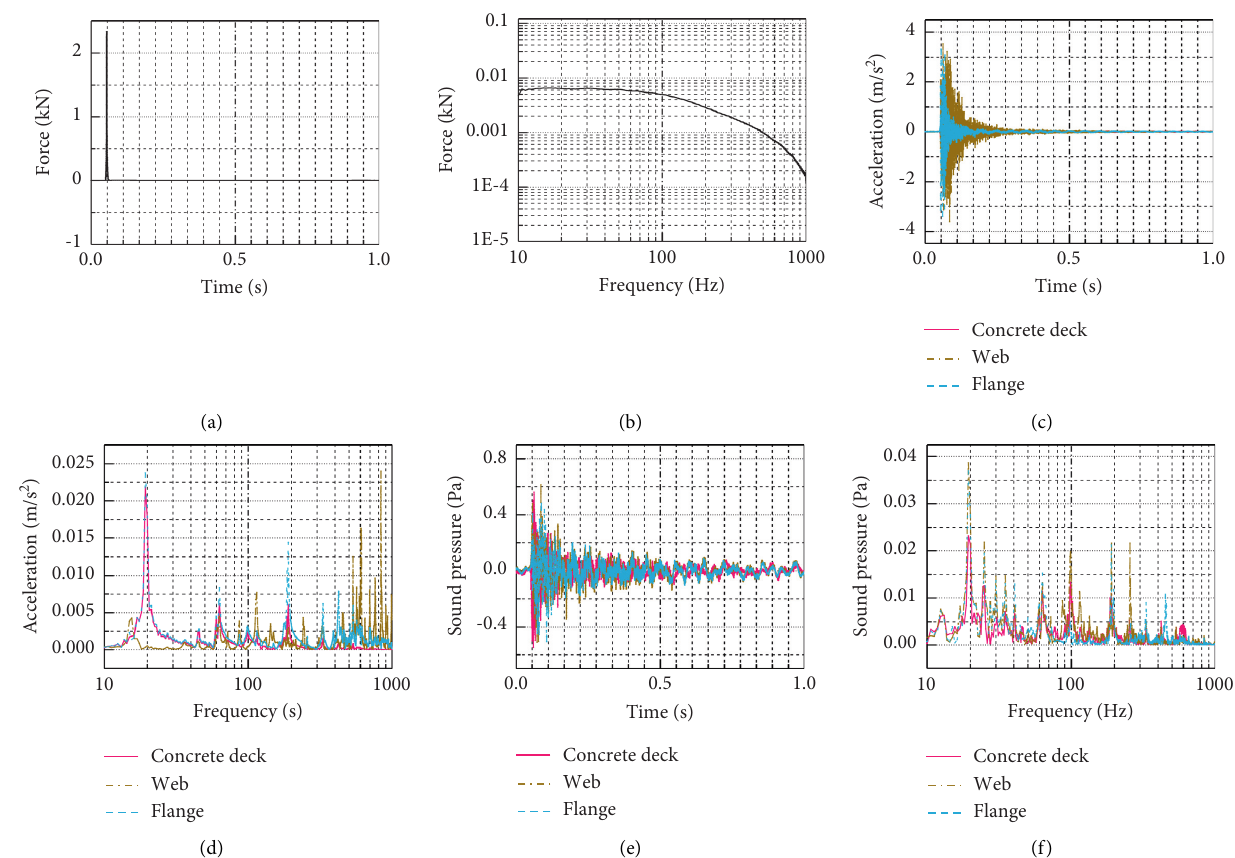
Figure 5: The measured data from one hammering. (a) Force (time domain). (b) Force (frequency domain). (c) Acceleration (time domain). (d) Acceleration (frequency domain). (e)Sound pressure (time domain). (f) Sound pressure (frequency